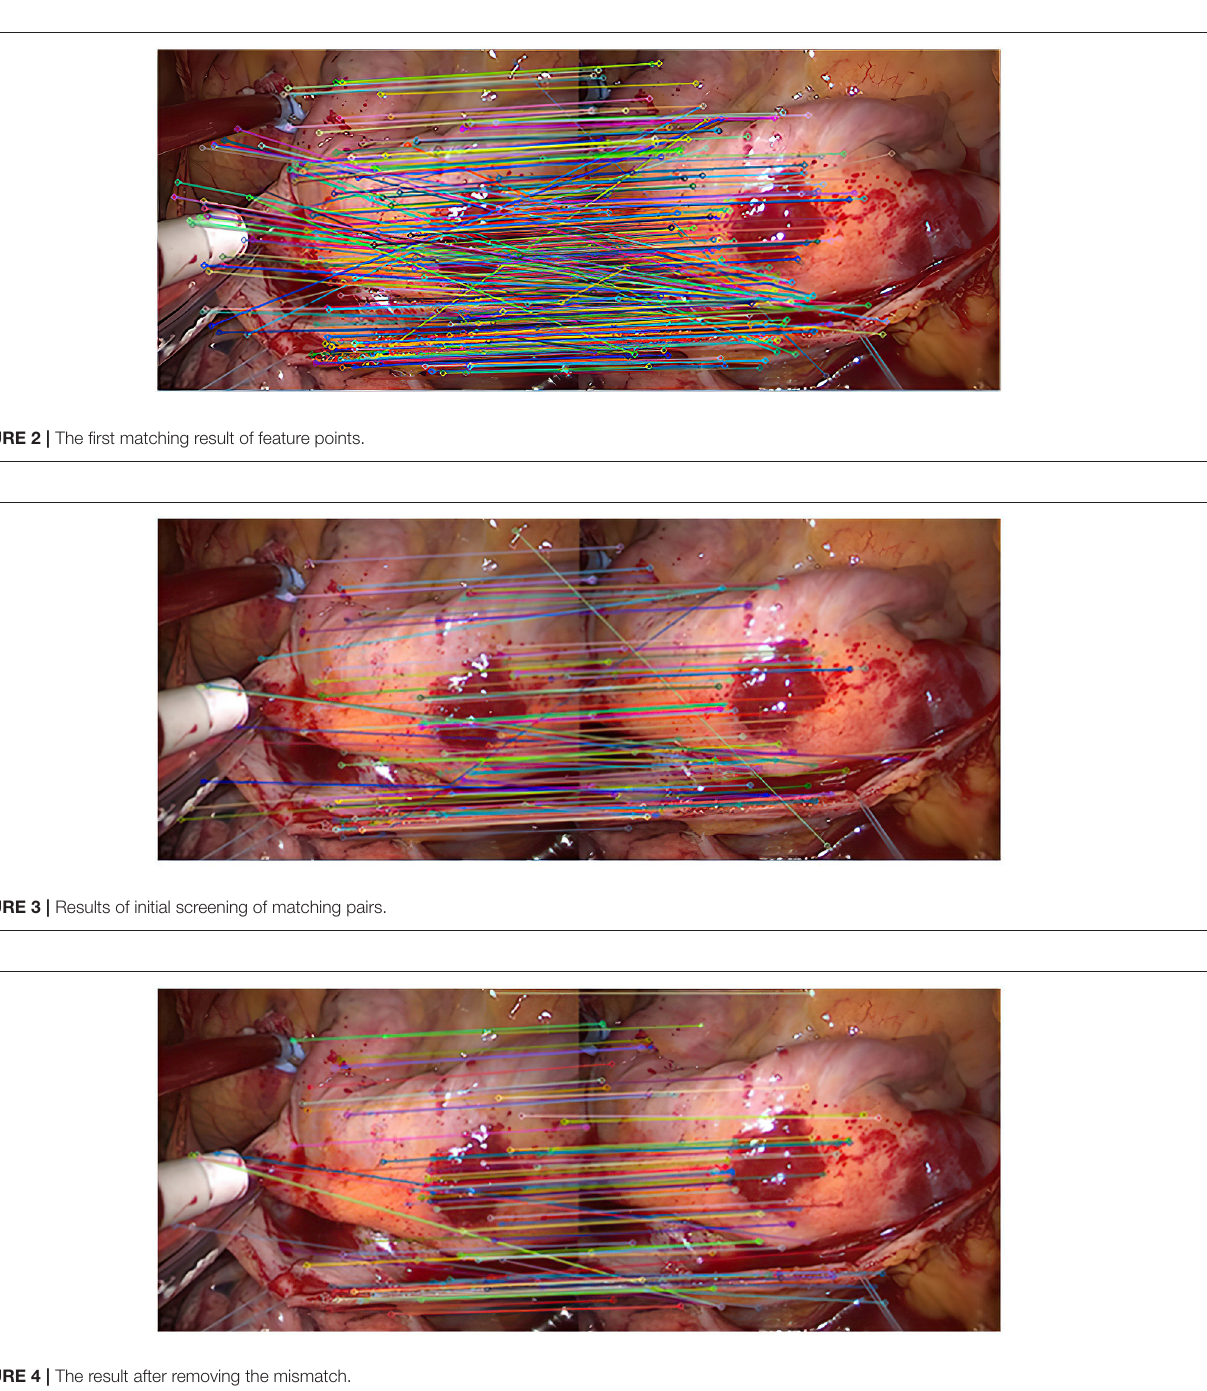
FIGURE 4 | The result after removing the